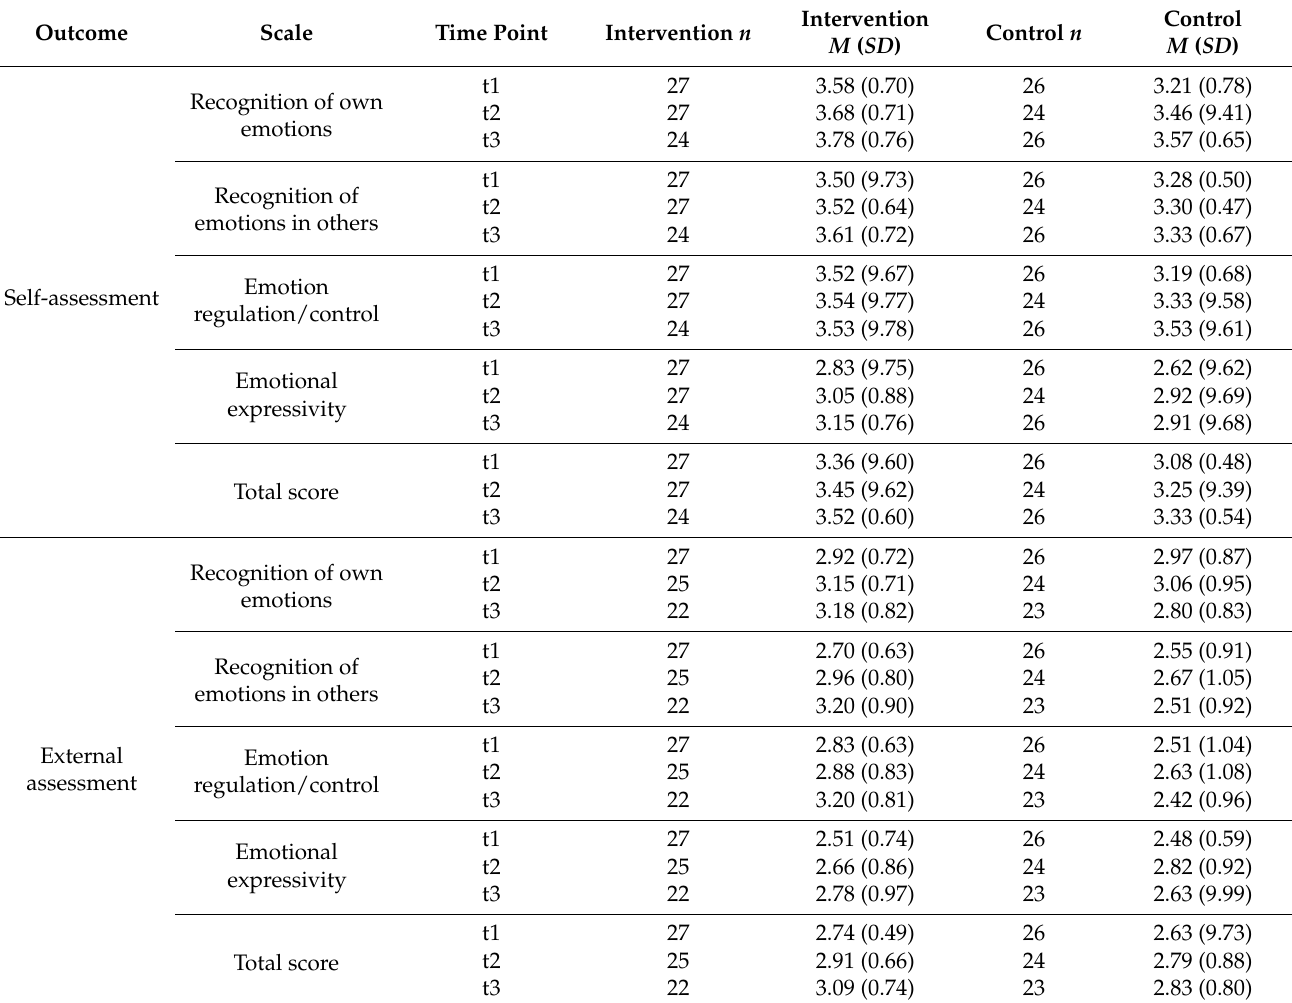
Table 2. Development of emotional competences over time for the intervention and the control